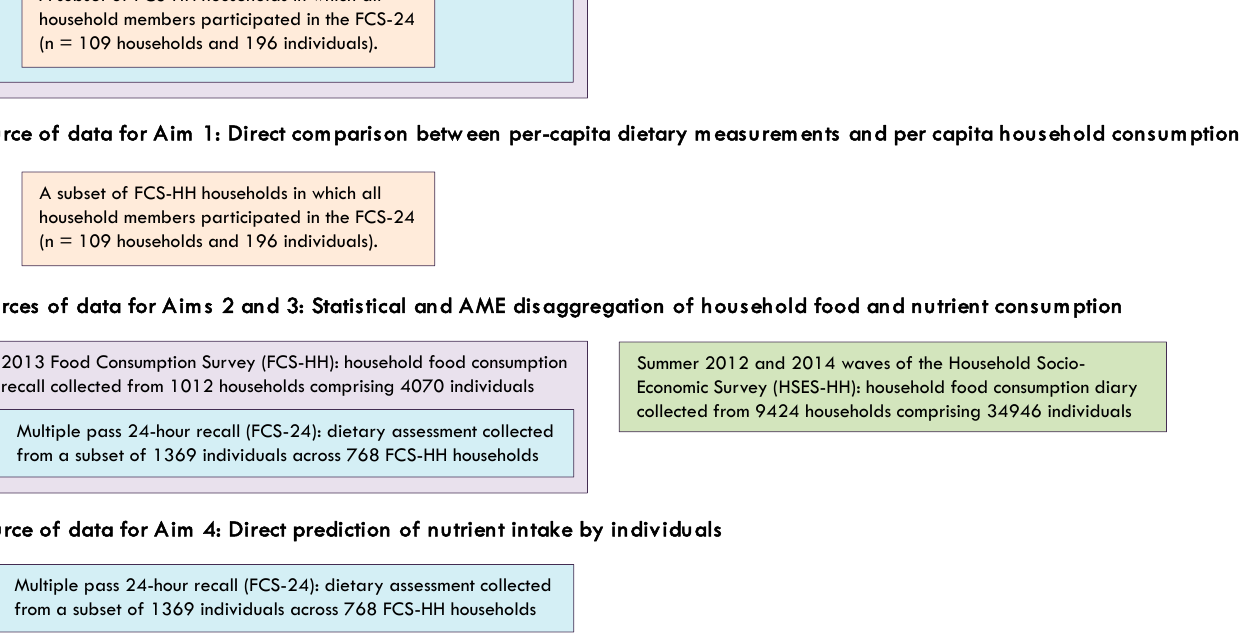
Figure 1. Sources of data. See Methods for description of exclusion criteria and information regarding ancillary diet records and national census data used in preparing and analyzing the 2013 Food Consumption Survey (FCS-HH), nested 2013 Food Consumption Survey-24-h (FCS-24), and Household Socio-Economic Survey (HSES-HH).